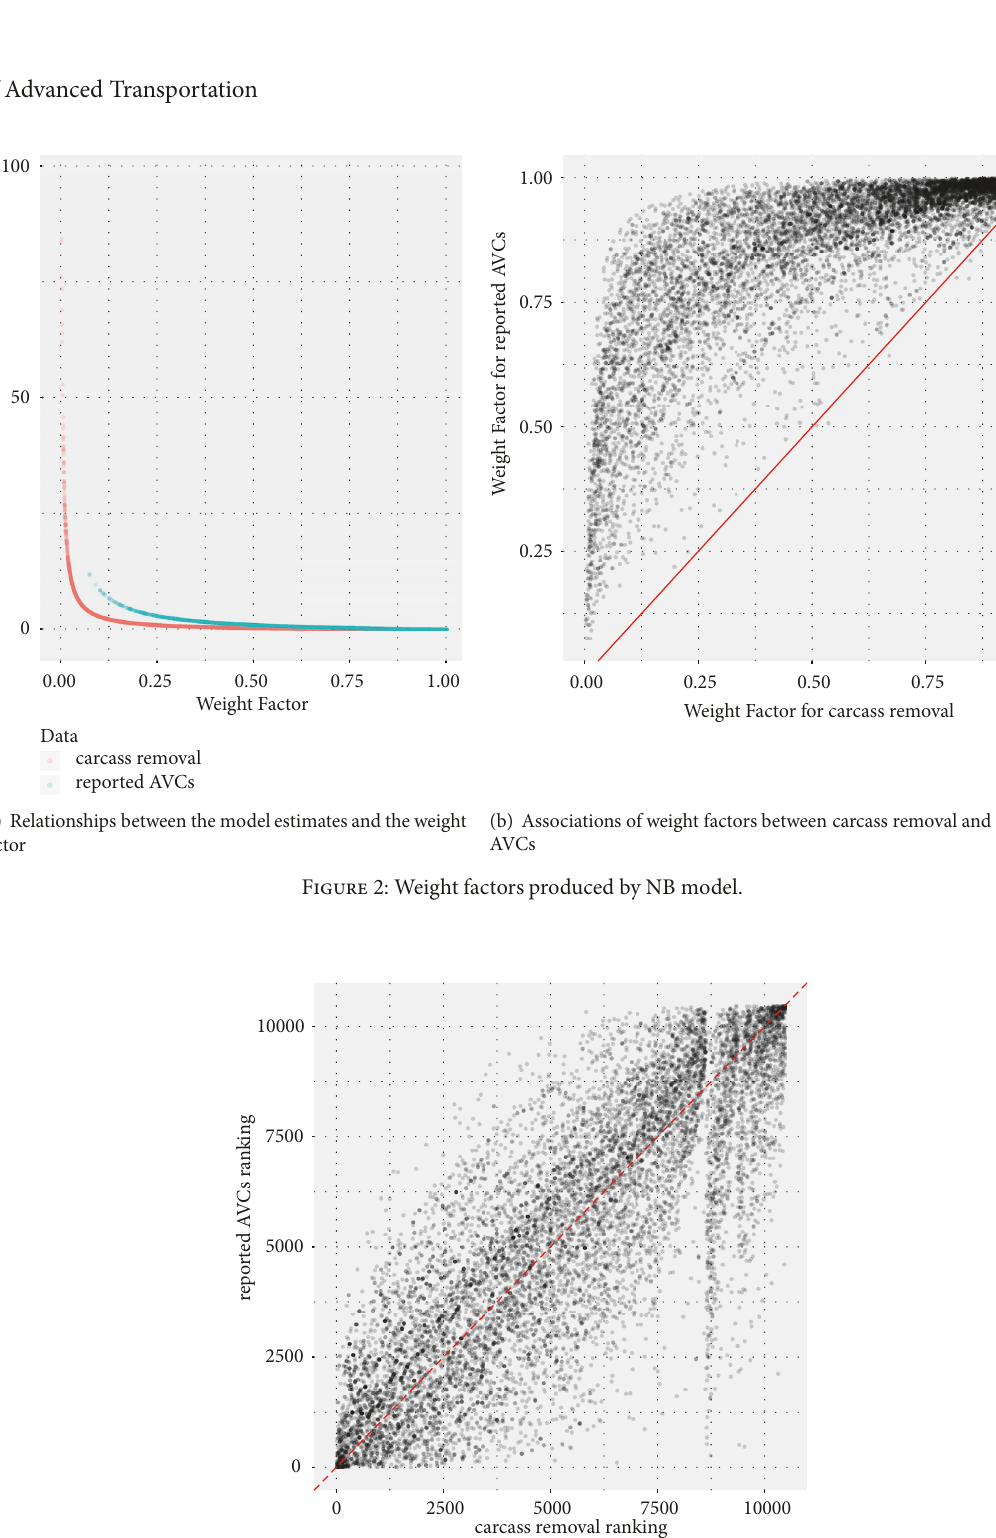
10,475). On the whole, the type of the data will influence the identification of dangerous